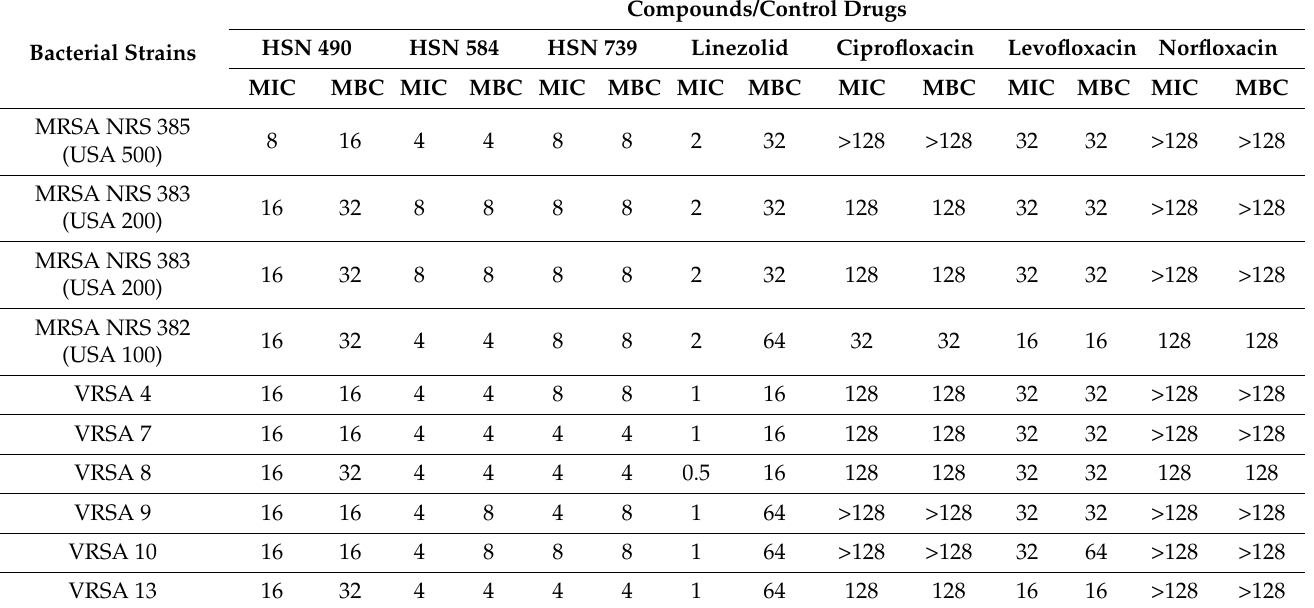
Table 2. The minimum inhibitory concentrations (MICs in µ g/mL) and minimum bactericidal con- centrations (MBCs in µ g/mL) of HSN compounds against fluoroquinolone-resistant S. aureus